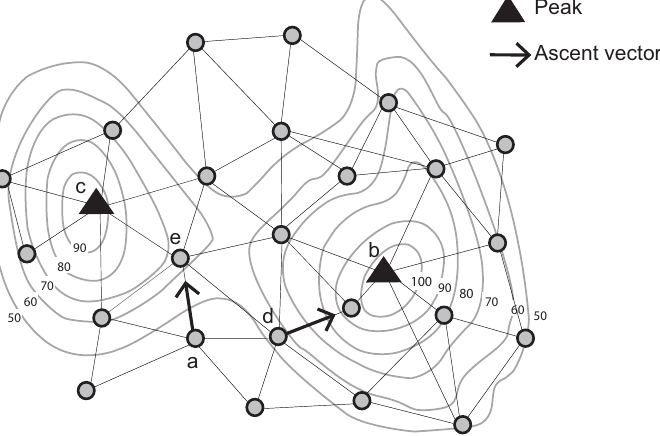
Figure 9. Example asynchronous update problem. The node a was previously a